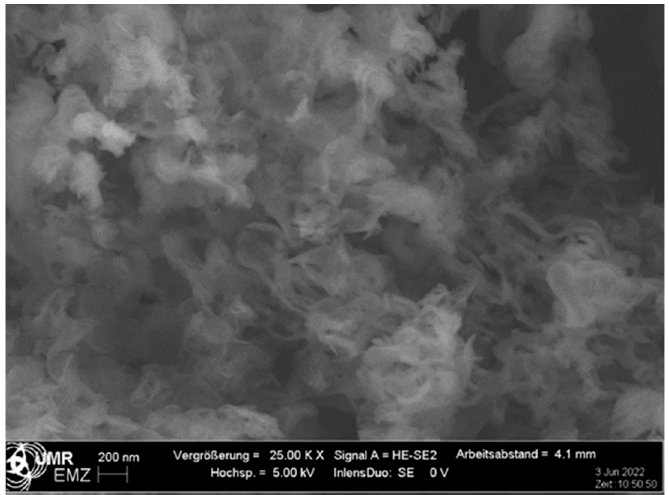
Figure 3. SEM image of 6 wt% NCQD/CNS (CNQD-6).